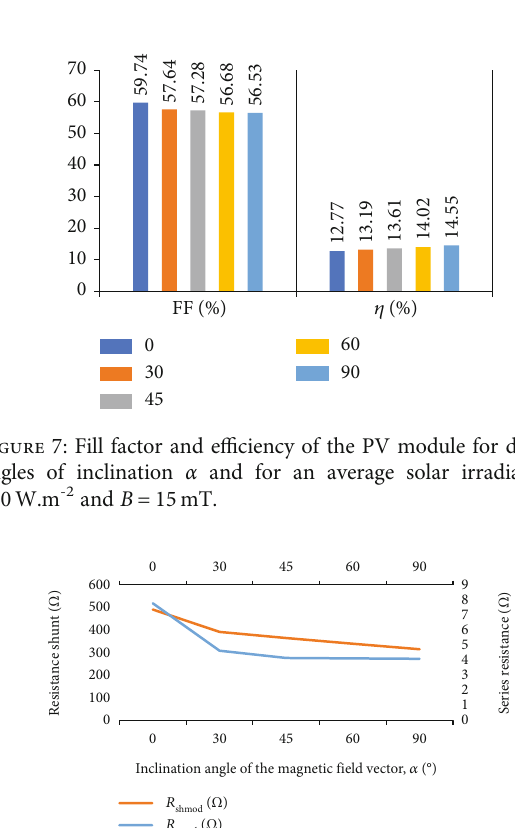
Figure 6: Characteristic parameters ( P of the PV module for di ff erent angles of inclination and for an average irradiance of 630W.m -2 and B = 15 mT.